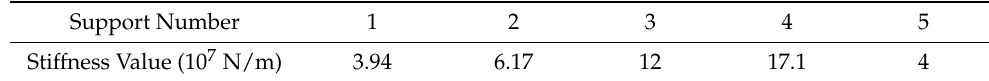
Table 1. Stiffness values of supports.